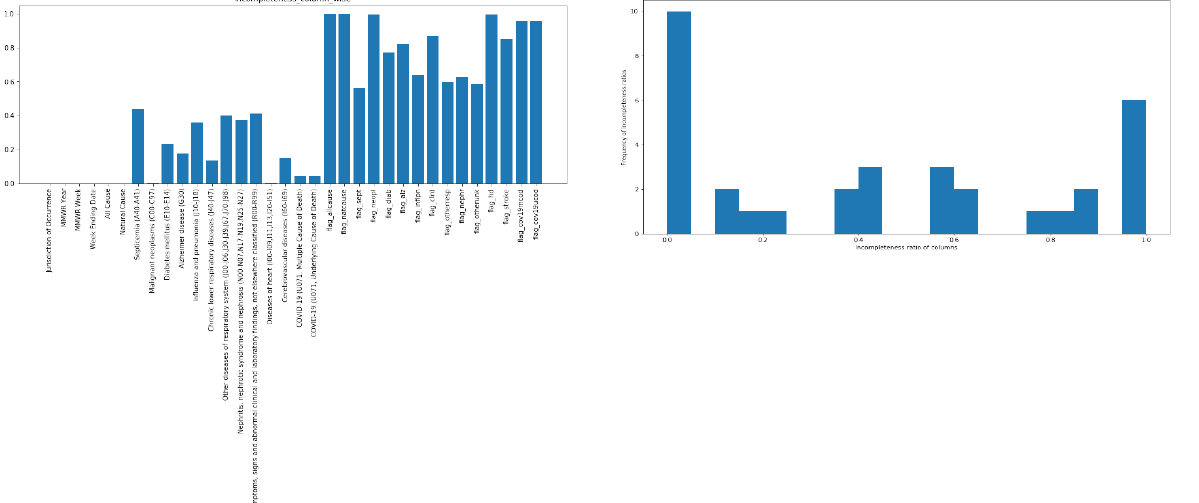
Figure 10. RIS of each column, histogram of Provisional Counts of Death Dataset.